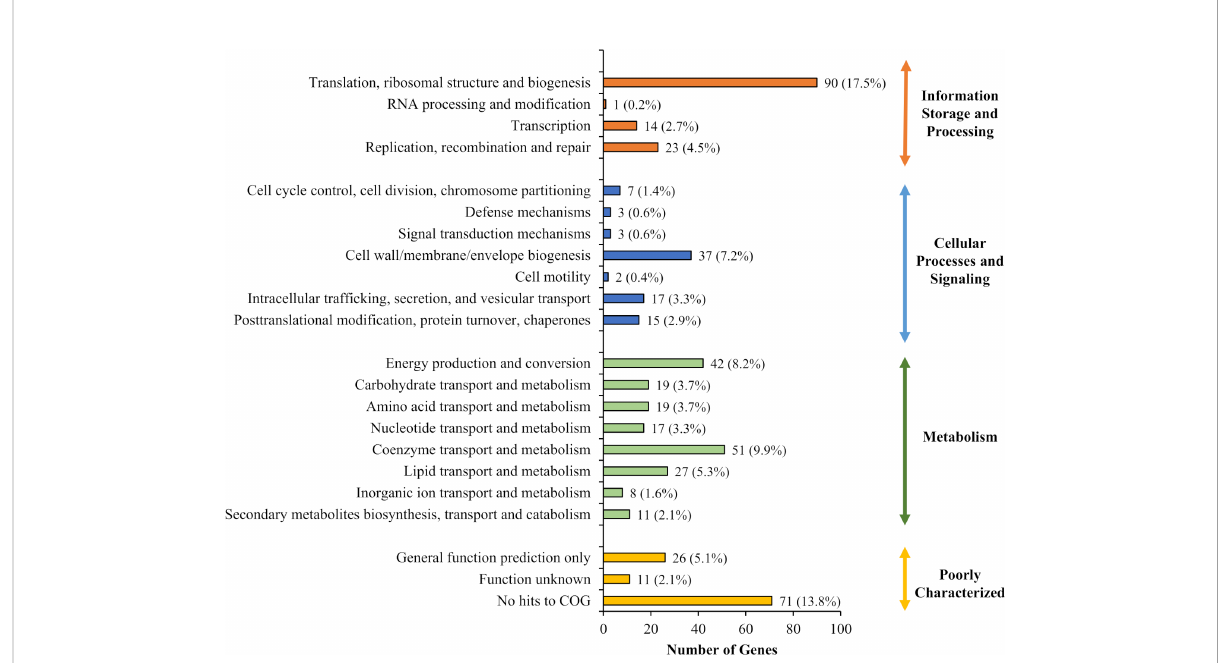
FIGURE 2 Functional analysis of candidate essential genes of B. pseudomallei R15. Distribution of 492 B. pseudomallei R15 essential genes (input pool) in each COG functional